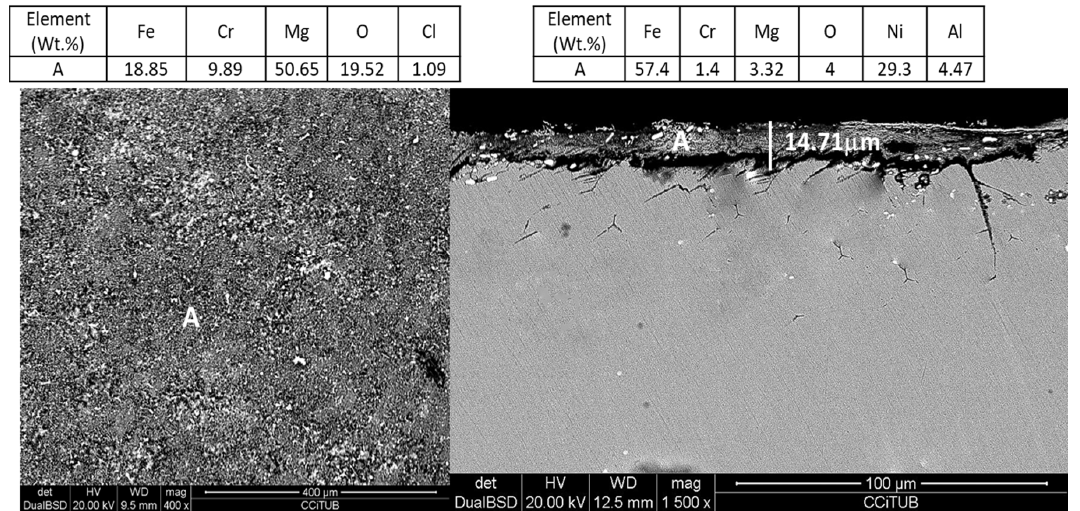
Figure 4. Micrographs showing a top view (left) and a cross section (right) of OC4 immersed in ternary chloride molten salt for 8 h at 720 °C; Energy dispersive X-ray (EDX) analysis on top.